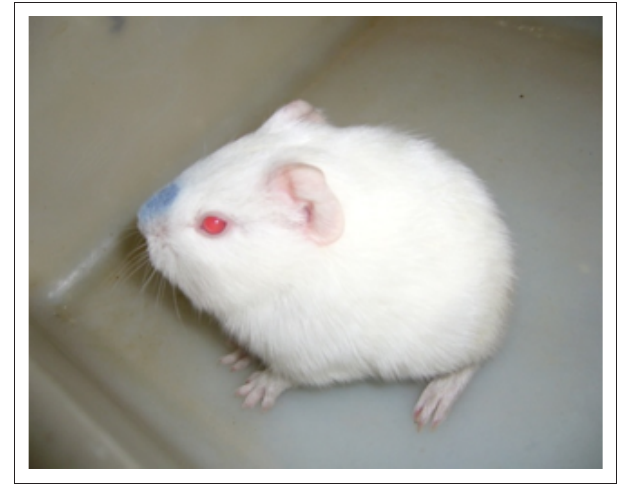
Source : Photographed by R.A. Schultz FIGURE 4: Guinea pig 12 h after dosing with diplonine, showing paresis in the hindquarters (mildly affected).